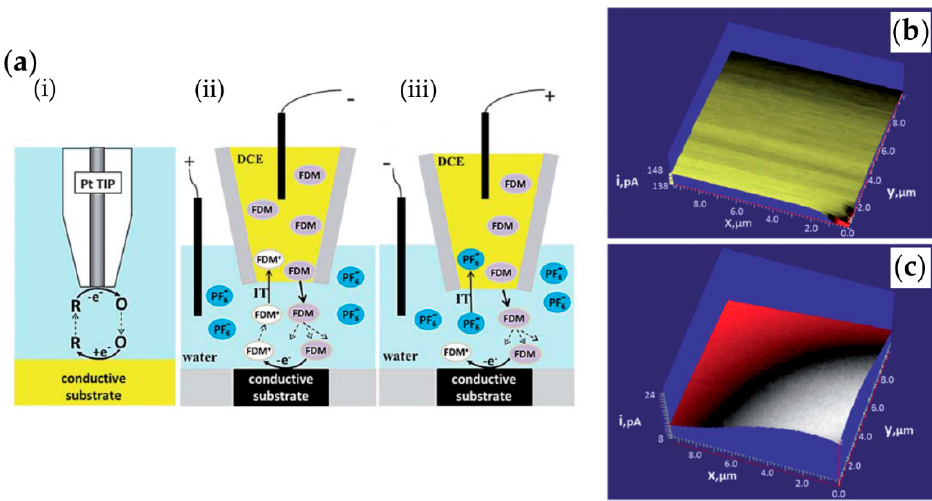
Figure 3. Electron transfer/ion transfer (ET/IT) mode of SECM for imaging a 12.5 µm radius Pt disk substrate. External (aqueous) solution contains 1 mM LiPF 6 , and the pipette is filled with 26 mM ferrocenedimethanol (FDM) in 1,2-dichloroethane (DCM) (organic). ( a ) Schematics of (i) the feedback mode of SECM in which a reduced species (R) is oxidized at the Pt tip electrode to form the oxidized species (O) that can be reduced at the conducting substrate beneath the tip; (ii) the ET/IT mode with positive IT feedback; and (iii) the ET/IT mode with negative IT feedback. ( b ) Topography image of the substrate, produced by the negative IT current of PF 6 − IT, shows no features. ( c ) Substrate reactivity map arising from oxidation current of FDM partitioning from the filling solution. (Adapted from Reference [56] with permission of The Royal Society of Chemistry).